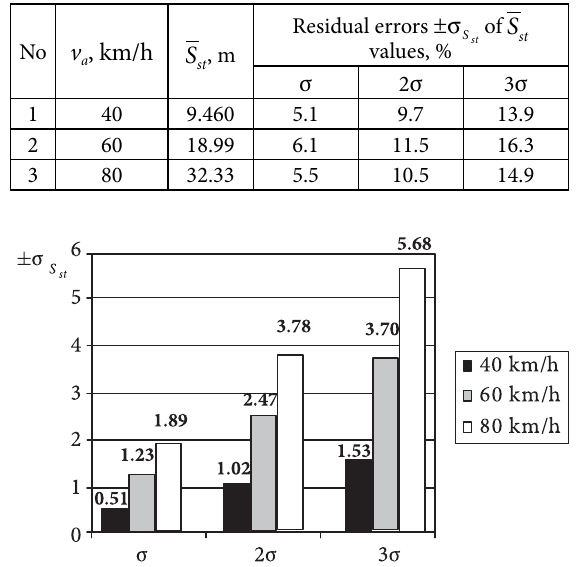
Fig. 6. Mean square deviations in accordance with “σ”, “2σ” and “3σ” rules from the prognosticated values of cars without/with ABS are evaluated